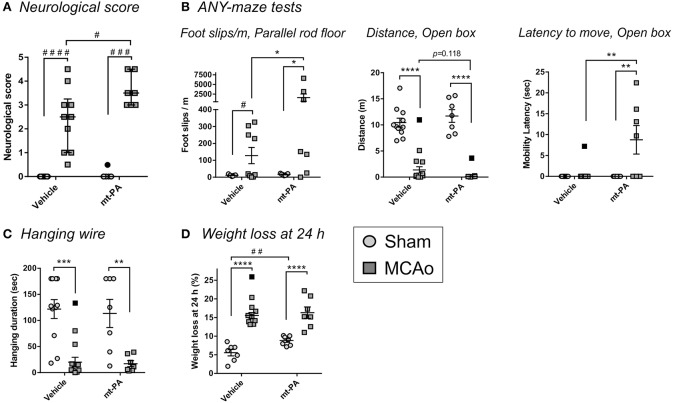
t-PA treatment worsens functional outcomes of middle cerebral artery occlusion (MCAo) in C57Bl/6 mice. Assessment of neurological deficit score (A), motor capacity on ANY-maze (B), hanging wire test (C), and weight loss (D) 23 h after sham surgery or transient MCAo (1 h) followed by treatment at reperfusion with HEPES vehicle or mouse t-PA (mt-PA; 0.9 mg/kg). MCAo robustly affects all functional parameters compared to sham, as expected, but administration of mt-PA significantly worsens post-stroke performance compared to vehicle [A,B (Foot slips & Latency) and a trend in B (Distance)]. Hanging wire test is not further affected by mt-PA (C). mt-PA-treated sham mice also significantly loose more weight compared to vehicle-treated controls (D). Data is shown as individual animals with median + IQR (A) or mean ± SEM (B–D). n = 7–11 for sham vehicle, 7 for sham t-PA, 8–10 for MCAo vehicle, 7 for MCAo t-PA. *p < 0.05, **p < 0.01, ***p < 0.001, ****p < 0.0001 by two-way ANOVA with Sidak's post-hoc, #p < 0.05, ##p < 0.01, ###p < 0.001, ####p < 0.0001 by the Mann–Whitney U-test (A) or by the student t-test (D). Outliers are denoted in black symbols and excluded from the analysis.